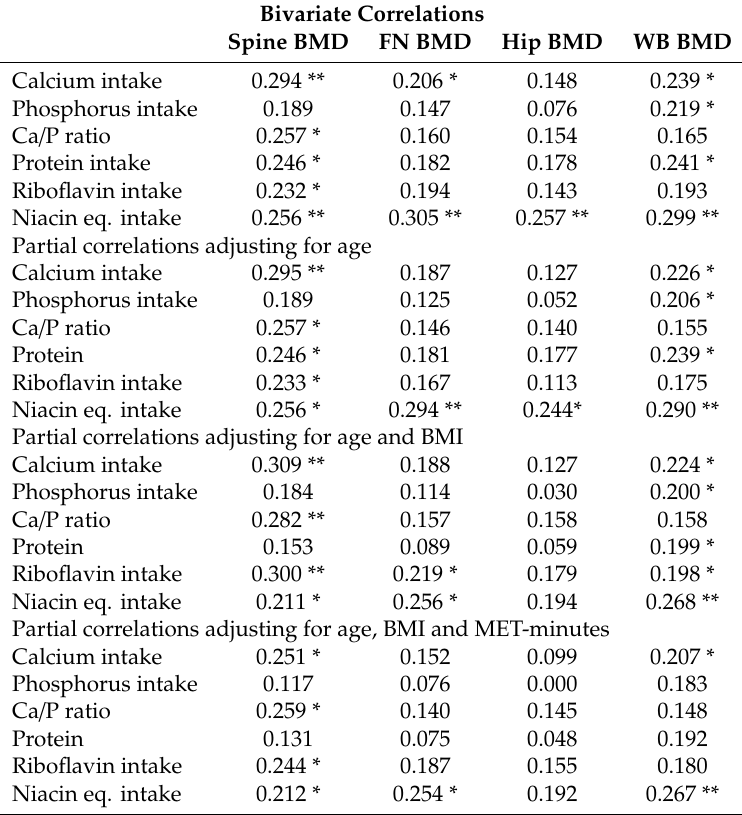
Table 4. Correlations between selected nutrient intakes, calcium / phosphorus ratio and bone mineral